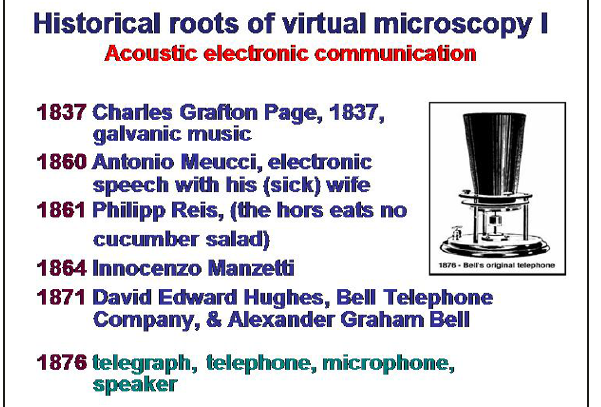
Figure 3 History of telemedicine related to the technological development